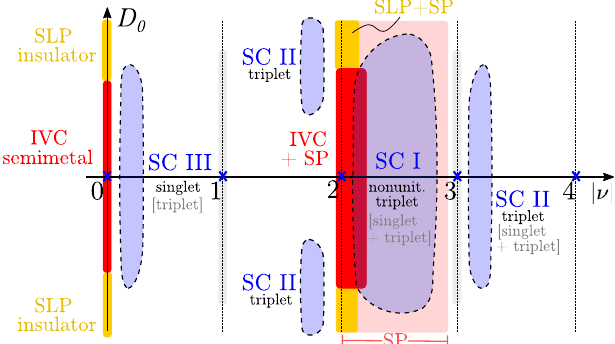
FIG. 1. Schematic phase diagram for MSTG based on our analysis, as a function of displacement field D 0 and filling fraction ν . Because of particle-hole symmetry of our model, the phase diagram depends only on j ν j . We show the form of the dominant particle-hole instabilities, the intervalley-coherent (IVC) semimetallic phase, and a sublattice-polarized (SLP) insulator at ν ¼ 0 (charge neutrality); the IVC and SLP state coexist with spin polarization (SP) around j ν j ¼ 2 . We discuss three different types of superconducting regimes labeled SC I – III. We indicate in black their respective spin structure for the expected sign of the intervalley Hund ’ s coupling J resulting H from Coulomb interactions alone (with opposite sign in